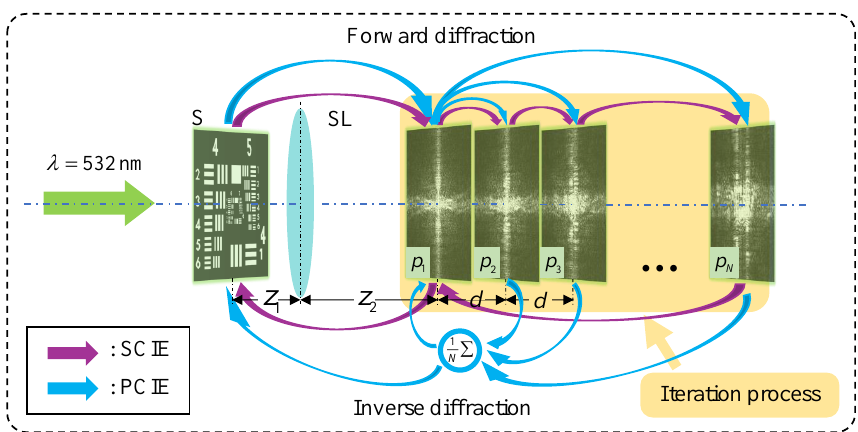
Figure 3. The flowchart of CIE. SL: single